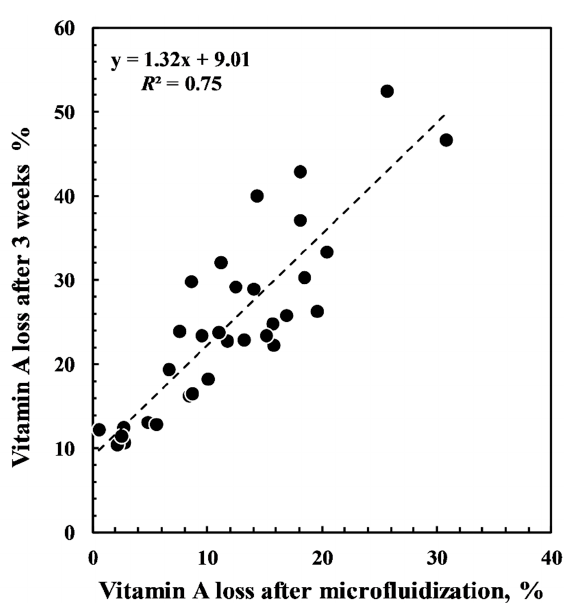
Figure 7. Correlation plot between percentage losses of vitamin A measured just after the microfluidizer step and after three weeks of storage.